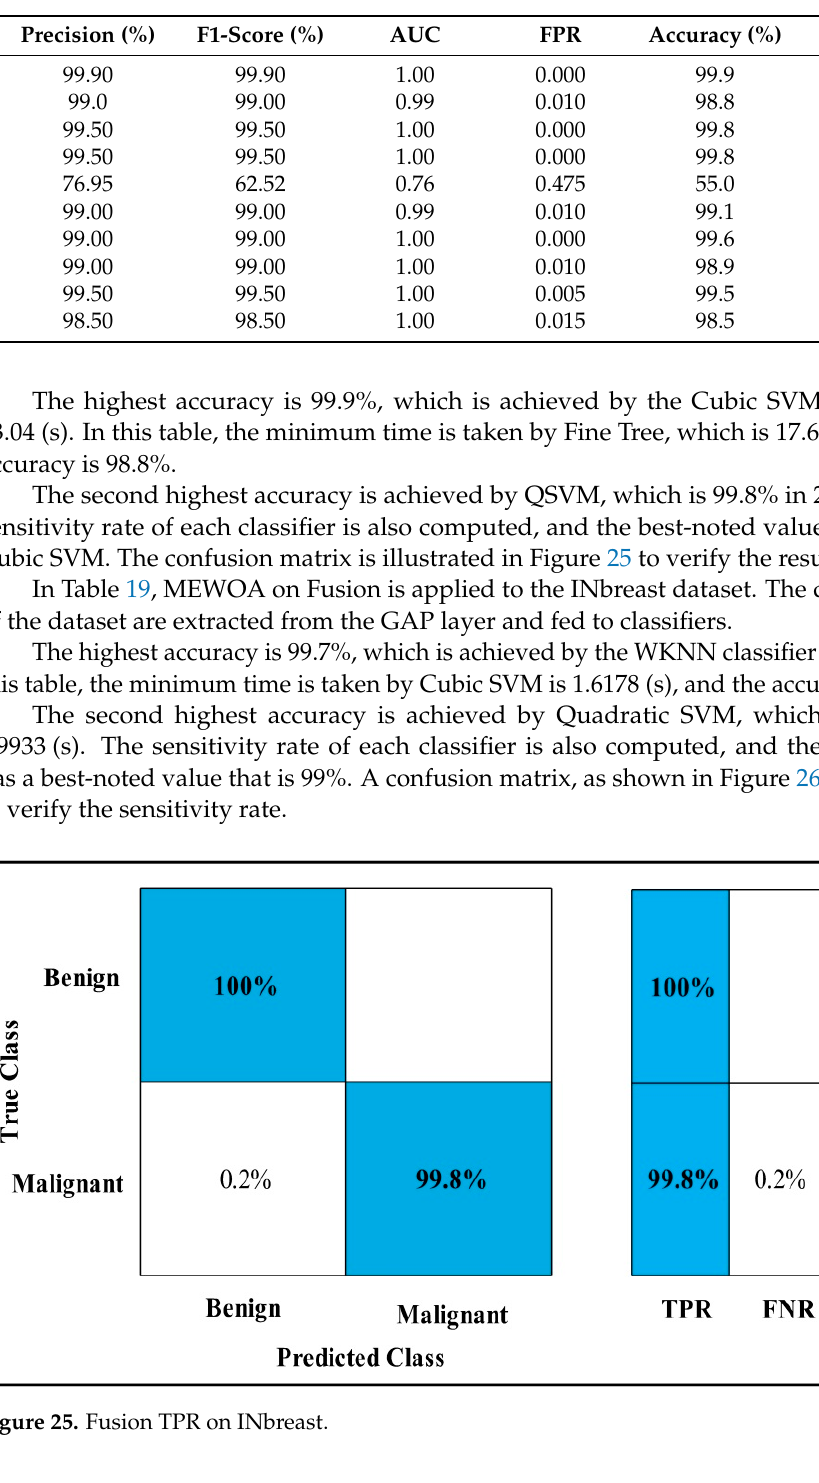
Table 18. Classification results using Fusion deep features for INbreast.